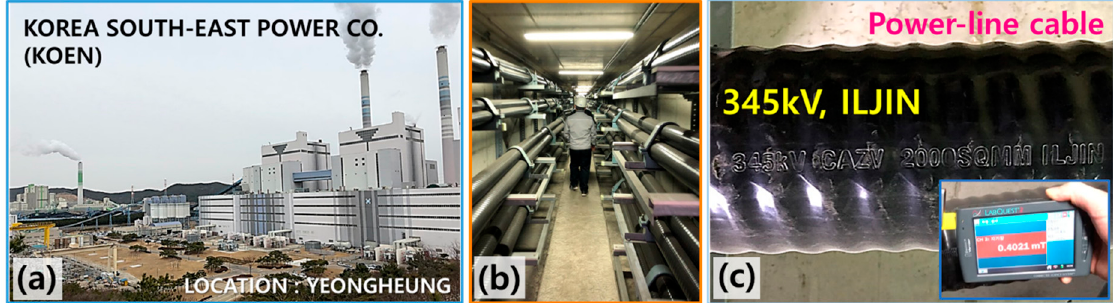
Figure 5. ( a ) Photograph of the thermal power plant with power-line cable. ( b ) Actual photo of power plant with power-line cables. ( c ) Photograph of the 345 kV power-line cable installed at the power plant.